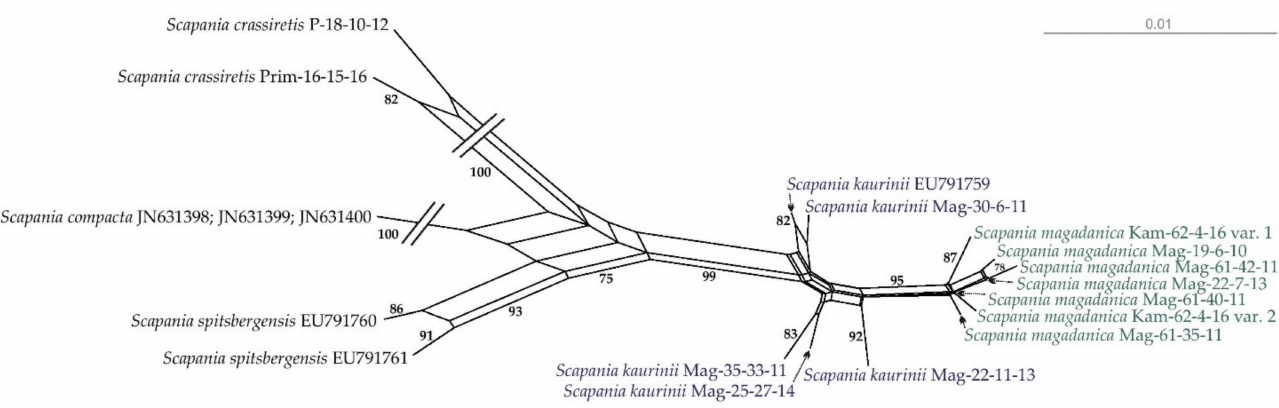
Figure 2. TCShaplotypenetworkofITS1–2sequences. Dashesindicatethenumberofnucleotidesubstitutions.